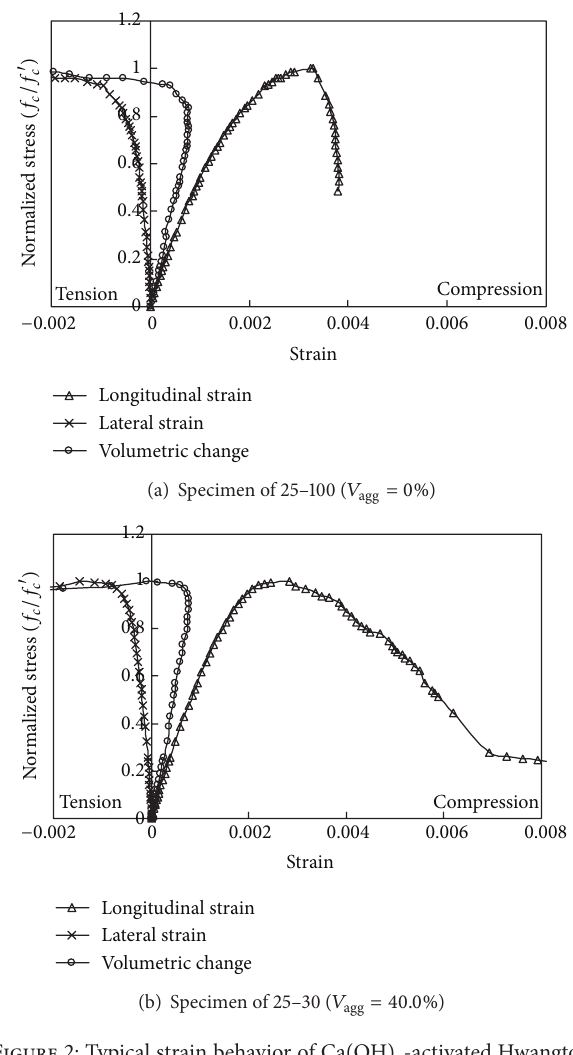
Figure 2: Typical strain behavior of Ca(OH) 2 -activated Hwangtoh concrete under axial compressive load.